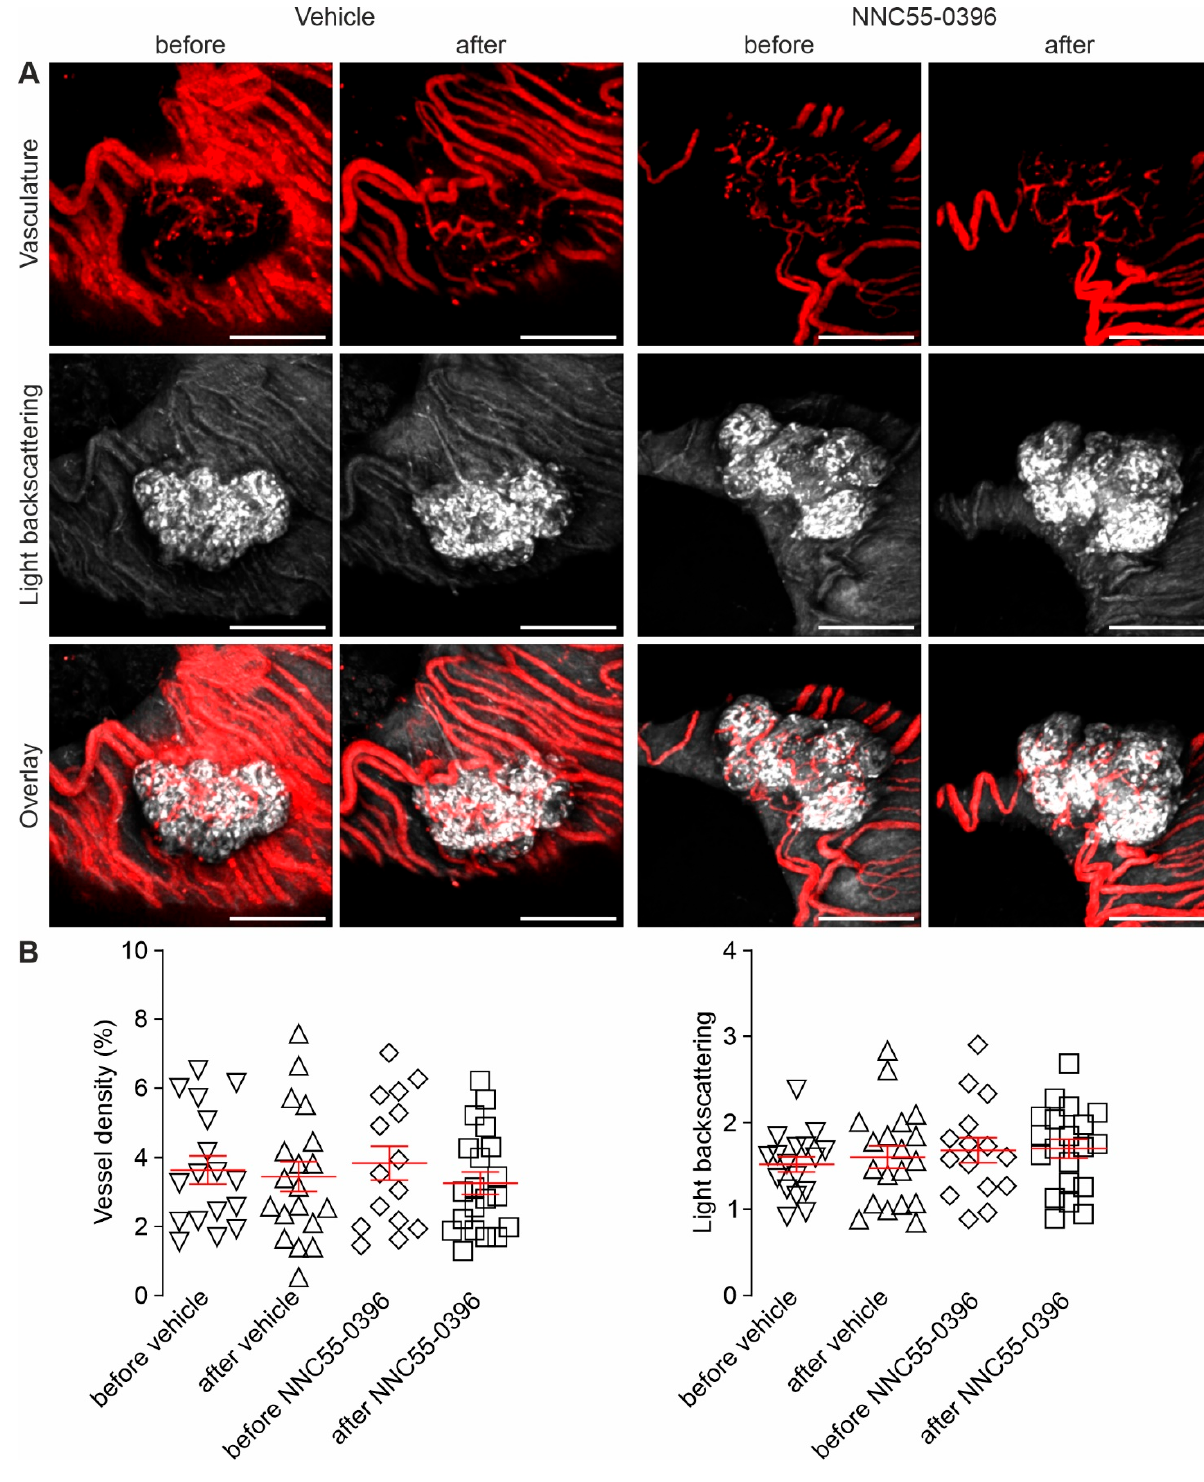
Figure 4. Effects of intravitreal infusion of NNC55-0396 on vascularization of and light backscatter from intraocular hiPSC-islet grafts. ( A ) Representative in vivo confocal images of the Qtracker 565- labelled vasculatures ( upper ) in and backscattered light ( middle ) from a single intraocular hiPSC-islet graft and their overlays ( lower ). Scale bar = 200 µ m. ( B ) Quantification of vessel density (n = 17 for group before vehicle, n = 19 for group after vehicle, n = 15 for group before NNC55-0396, n = 20 for group after NNC55-0396) and light backscattering intensity (n = 17 for group before vehicle, n = 19 for group after vehicle, n = 15 for group before NNC55-0396, n = 20 for group after NNC55-0396) in single intraocular hiPSC-islet grafts before and after intravitreal infusion of vehicle or